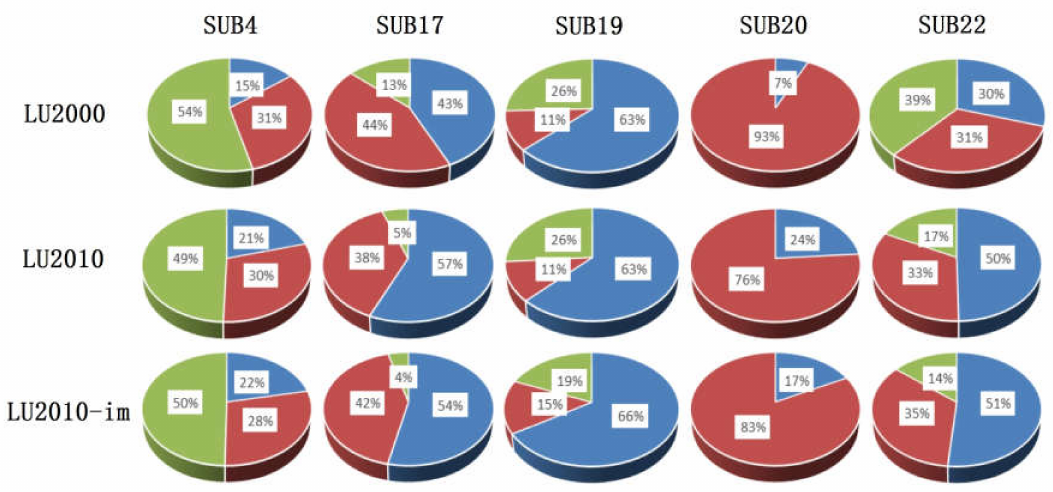
Figure 7. Flow components (surface runoff, lateral flow and groundwater flow) within sub-basins (represented as pie charts (%); annual values averaged over six years,